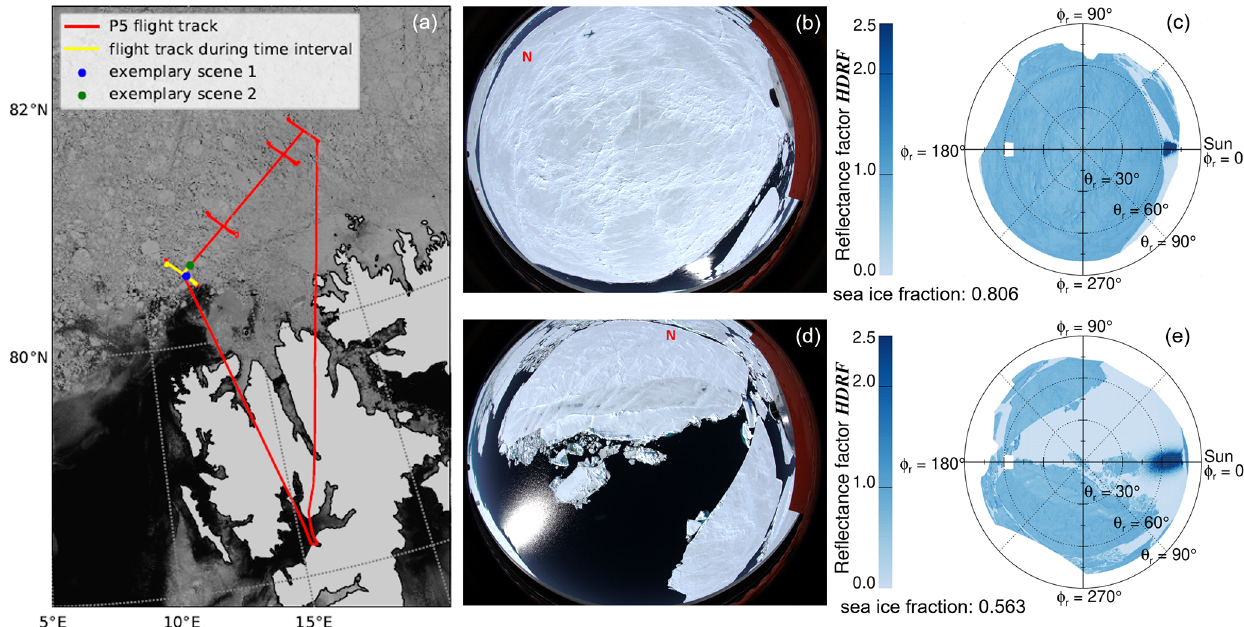
Figure 1. (a) Satellite image (composed of MODIS bands 1 and 2) of the MIZ north of Svalbard observed on 25 June 2017, 12:45UTC, including the flight track of Polar 5 (red). The 20min period used for the analysis is highlighted in yellow. The blue and green dots indicate the locations where the exemplary scenes in (b) and (d) , respectively, were observed. Panels (b) and (d) show exemplary images taken by the fish-eye camera at 12:37:23 and 12:46:41UTC, respectively. Panels (c) and (e) present the processed HDRF polar plots of the scenes shown in (b) and (d) , respectively. Note that the polar plots are rotated compared to the raw images in a manner that the solar incident direction is always to the right of the